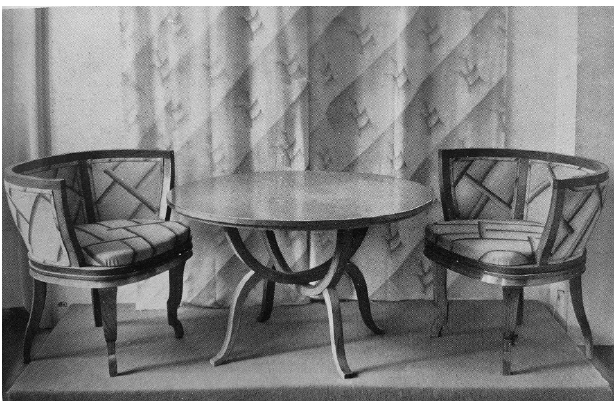
Figure 10. Fides Testi, curtain decorated by airbrush for the hall of Ente Nazionale Piccole Industrie alla Biennale di Monza in 1930 and furniture designed by Emanuele Cito. Photo from (Morelli 1931a) (present also in Morelli 1933a). In public domain.